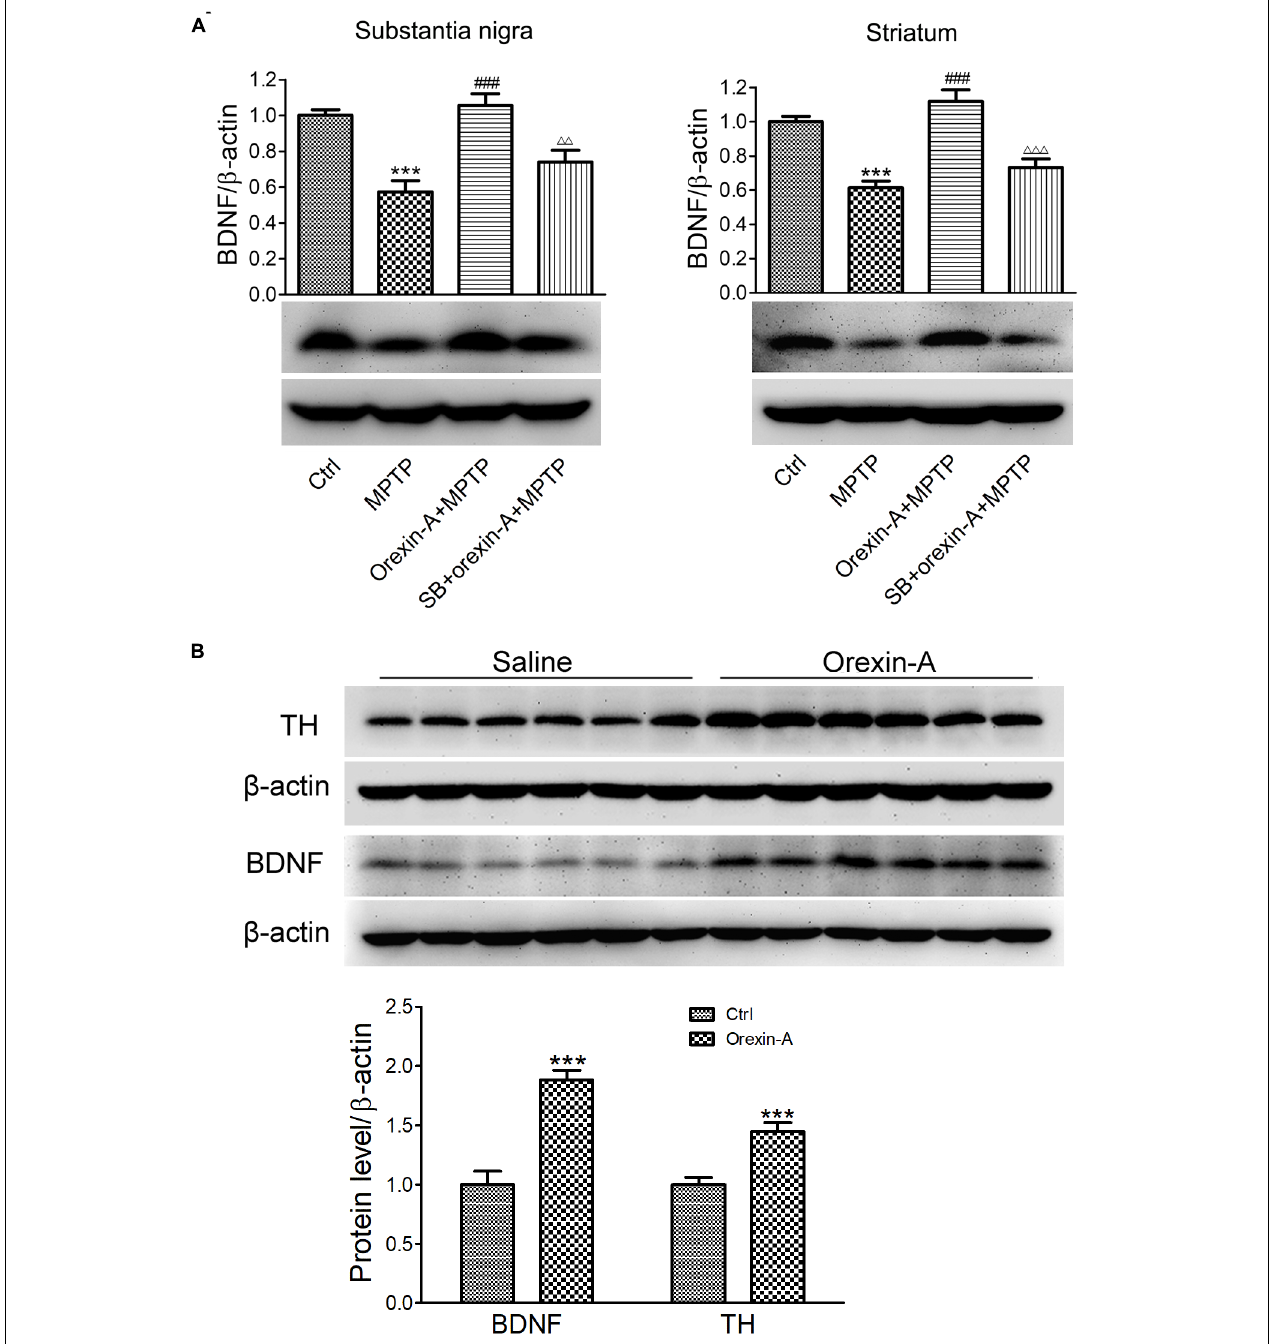
FIGURE 6 | Effects of orexin-A on the protein expression of BDNF. (A) Immunoblot analysis showing the protein expression of BDNF in the substantia nigra and striatum of MPTP parkinsonian mice. Average protein level was quantified as ratios between BDNF and β -actin. (B) Immunoblot analysis showing the effects of orexin-A on protein expression of BDNF in the striatum after 3 days of orexin-A injection in normal mice. Average protein level was quantified as ratios between BDNF or TH and β -actin. Each value represented mean ± SEM, n = 6. ∗∗∗ P < 0.001 vs. control; ### P < 0.001 vs. MPTP; (cid:77)(cid:77) P < 0.01, (cid:77)(cid:77)(cid:77) P < 0.001 vs. orexin-A + MPTP. SB: